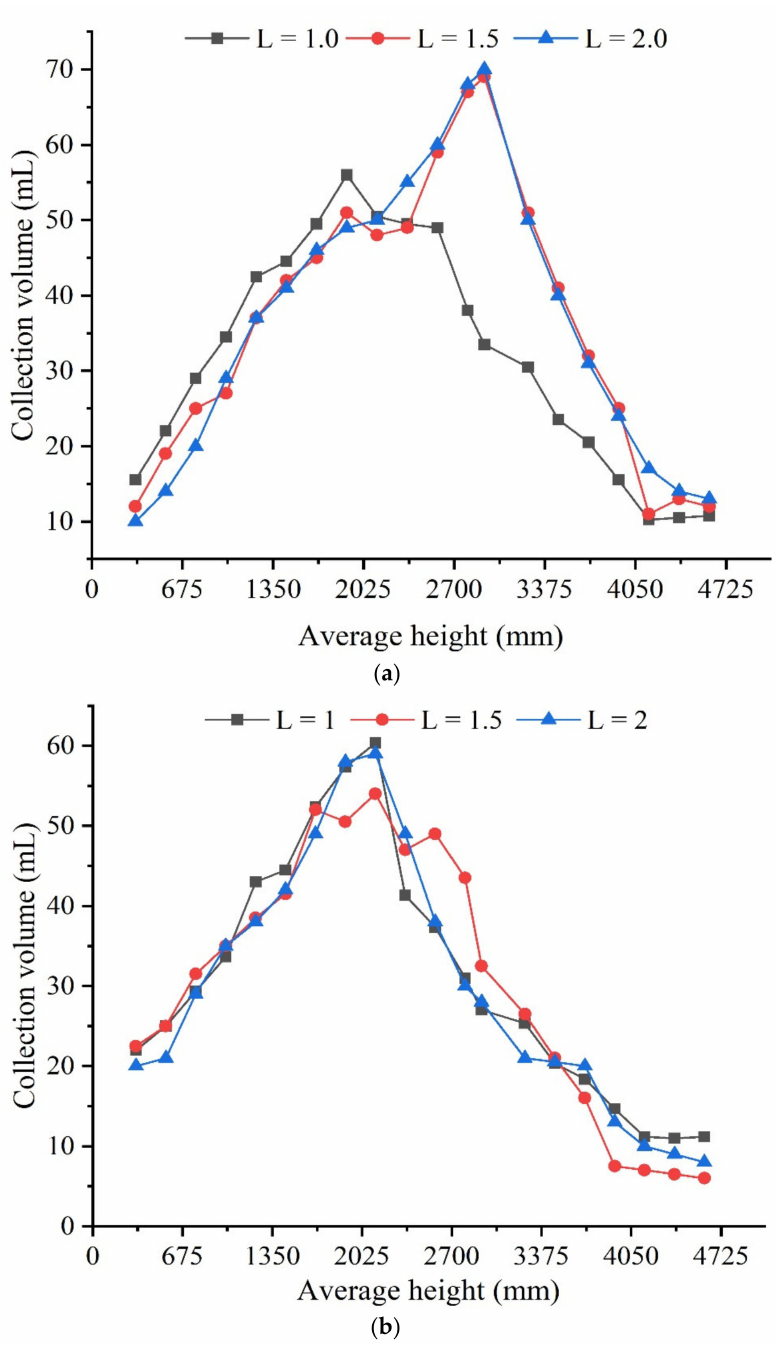
Figure 6. Influence of the spray distance on the collection volume at different blower speeds (W = 60 ◦ ). ( a ) Influence of the spray distance on the collection volume (N = 2800 r/min). ( b ) Influence of the spray distance on the collection volume (N = 2400